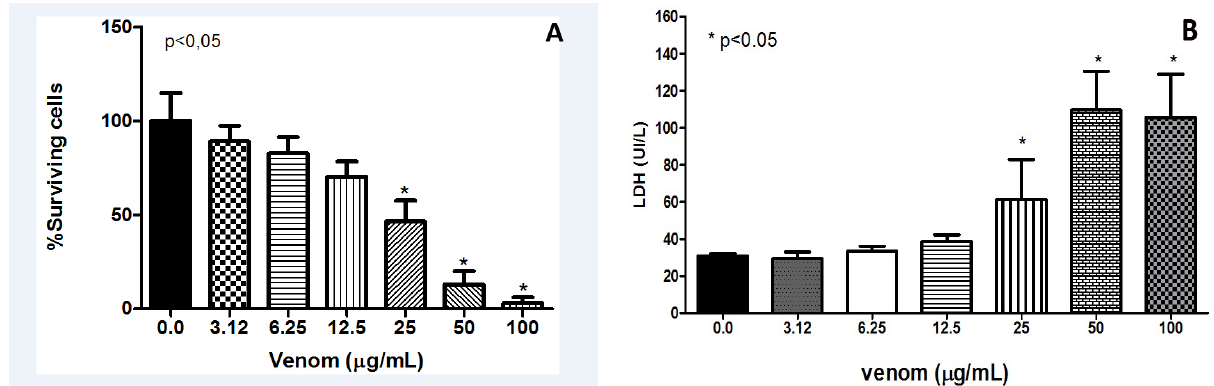
Figure 3. Cytotoxic effects of Polybia paulista venom (PPV; 3.12-100 µg/mL) on MDCK cells by ( A ) MTT and ( B ) lactic dehydrogenase assays. Data are expressed as means ± SEM, ANOVA, Bonferroni post-test, * p <